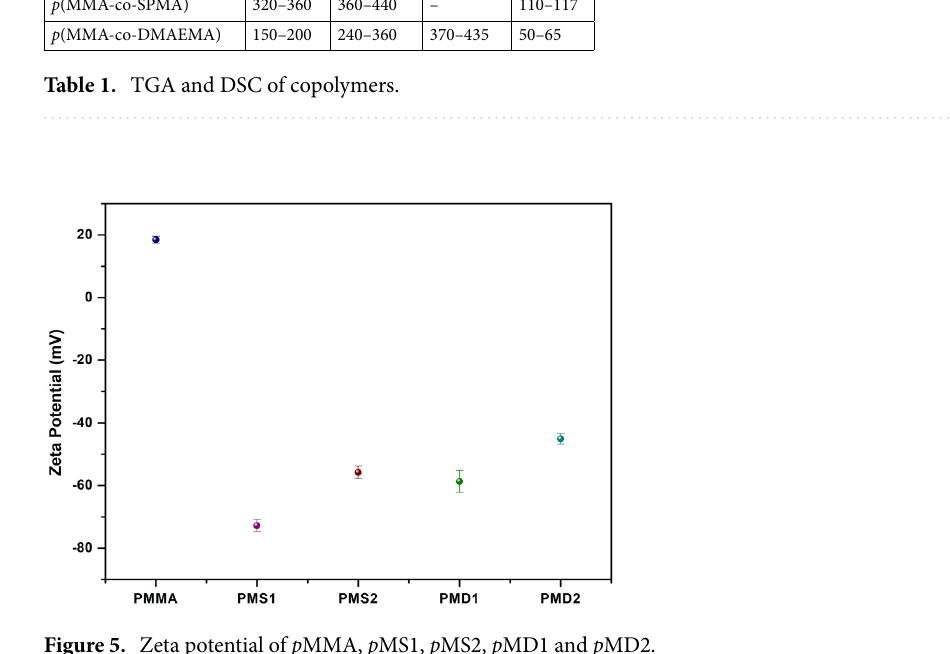
Figure 5. Zeta potential of p MMA, p MS1, p MS2, p MD1 and p MD2.